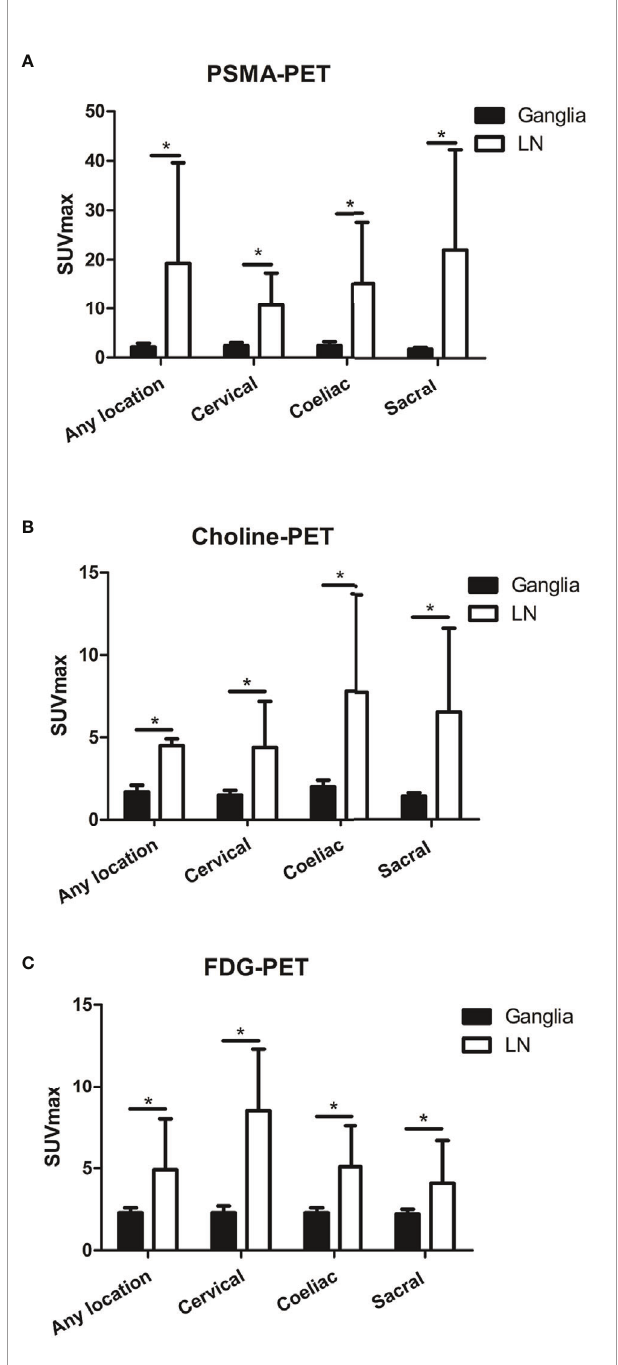
FIGURE 4 | The PSMA, choline and FDG uptake in ganglia and adjacent LNM. (A) The PSMA uptake in ganglia and adjacent LNM. (B) The choline uptake in ganglia and adjacent LNM. (C) The FDG uptake in ganglia and adjacent LNM. *P <